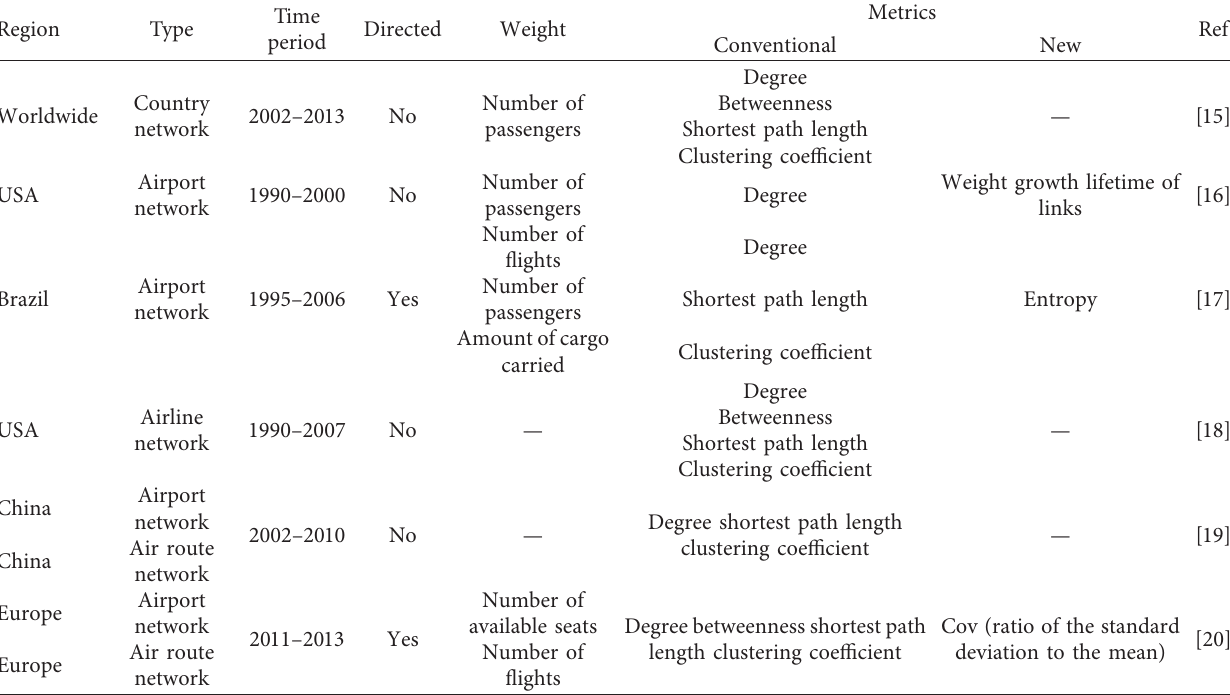
Table 3: Some strong impact temporal evolution analyses on air transport